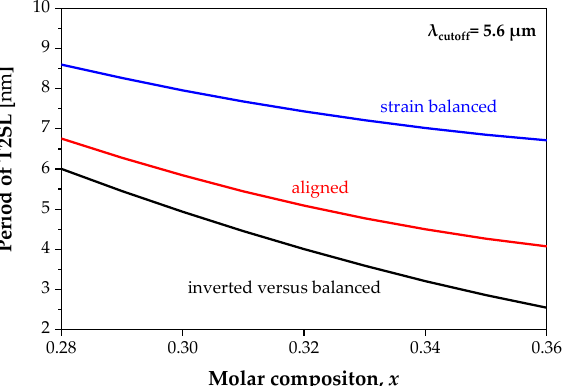
Figure 6. Theoretical simulation of the SL period versus molar composition x with the bandgap energy of 0.22 eV at T = 150 K.